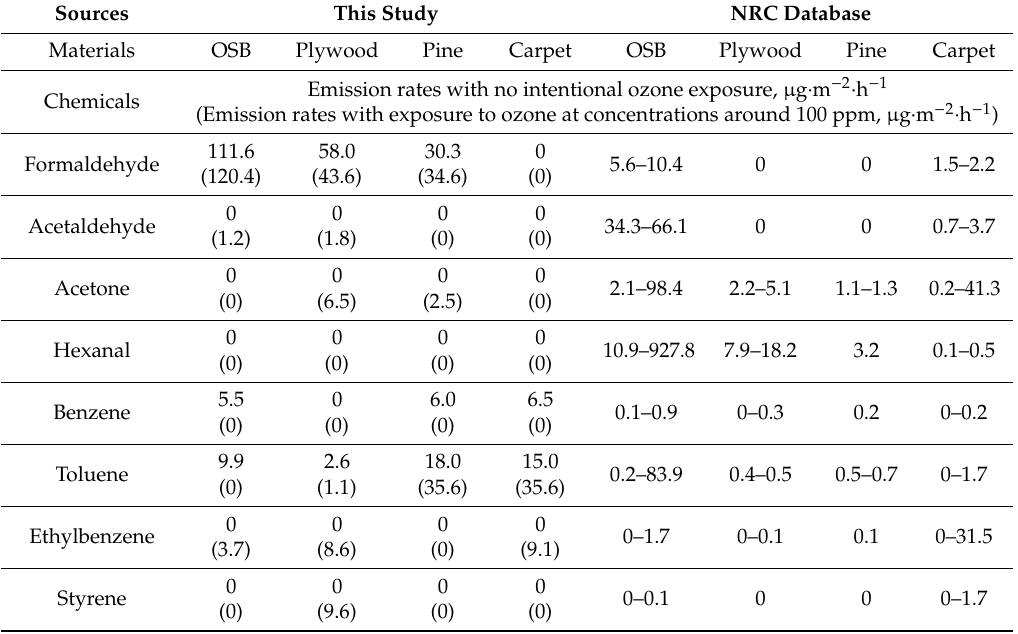
Table 7. Comparison of VOC emission rates determined in this study and from the National Research Council Canada (NRC)